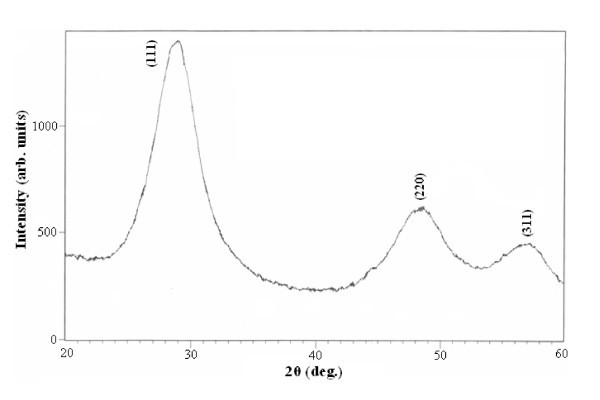
XRD pattern of Zn0.9900Mn0.0100S nanocrystals.